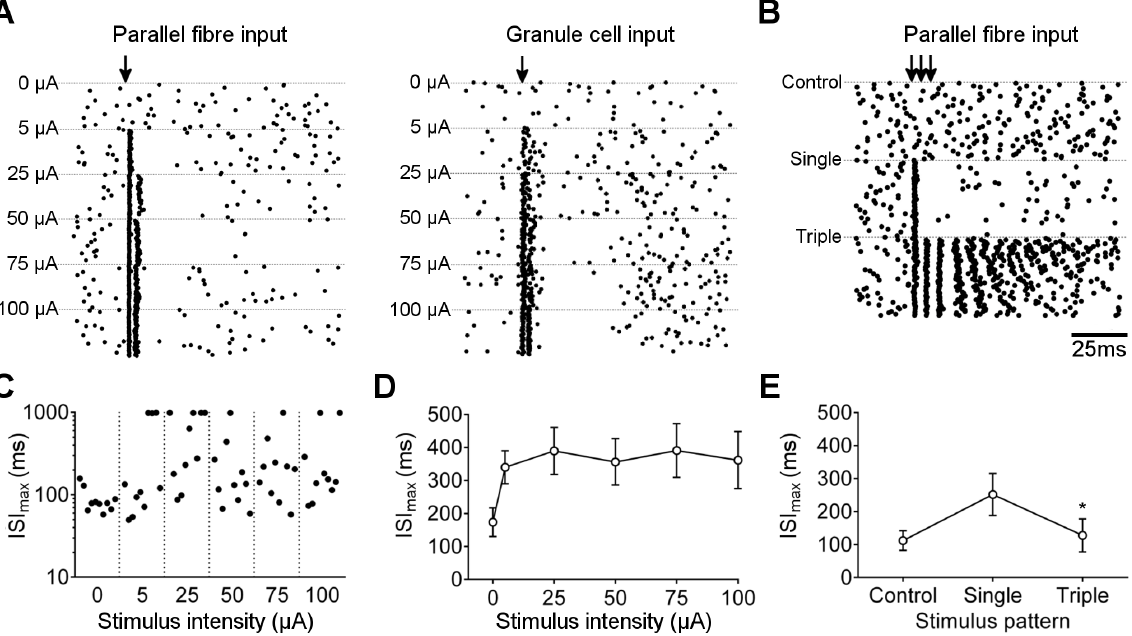
Figure 6. Effect of stimulus intensity on post-stimulus pause. A) Raster plot of 60 stimuli (arrow) at 0.2 Hz, with increasing stimulus intensity (0–100 m A as indicated), in the molecular layer (left panel) and granular layer (right panel). Note apparent gap in record post-stimulation. B) Raster plot as for panel A, with stimulation at 25 m A with single or triple pulse with 10 ms interval (as indicated). C) Raster plot of maximum post-stimulus interval (initiated within 50 ms of stimulus) for 10 representative responses at each stimulus intensity. Intervals of 1 s correspond to sweeps where no spikes were detected before the next stimulus. D) Mean 6 s.e.m. maximum post-stimulus interval against stimulus intensity. No significant differences (all p values . 0.05) were found between stimulus intensities or unstimulated cells (n=16; Multiple comparisons ANOVA with Tukey’s test for pairs). E) Mean 6 s.e.m. maximum post-stimulus interval for unstimulated cells, and single and triple pulse stimuli (n=17). *p=0.042, multiple comparisons ANOVA with Tukey’s test for pairs (adjusted p